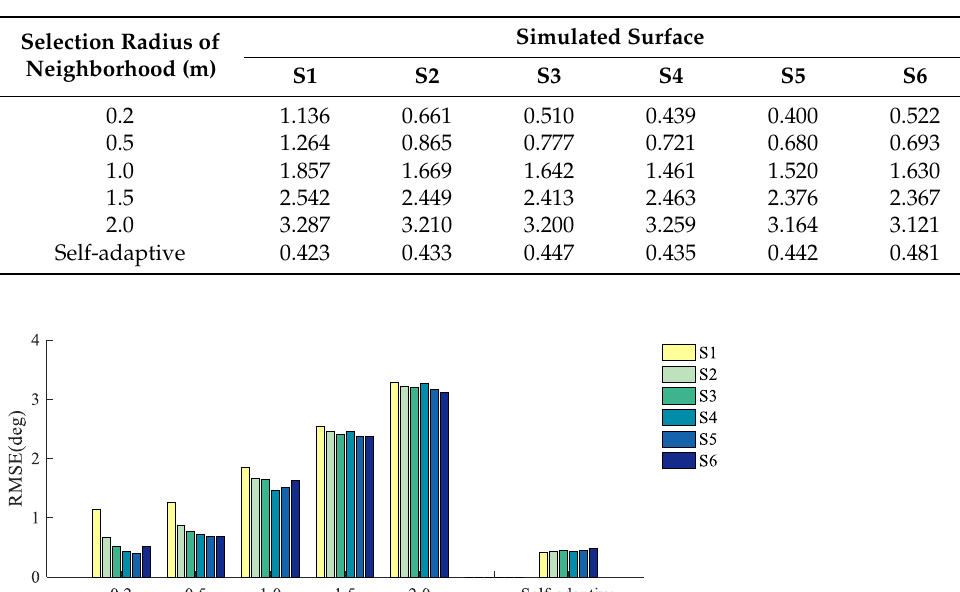
Table 8. Root mean square error of wave surface aspect estimation.